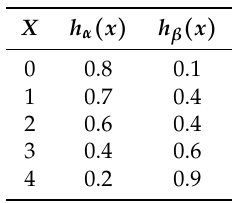
Table 2. Tabular representation of h = ( h α , h β )